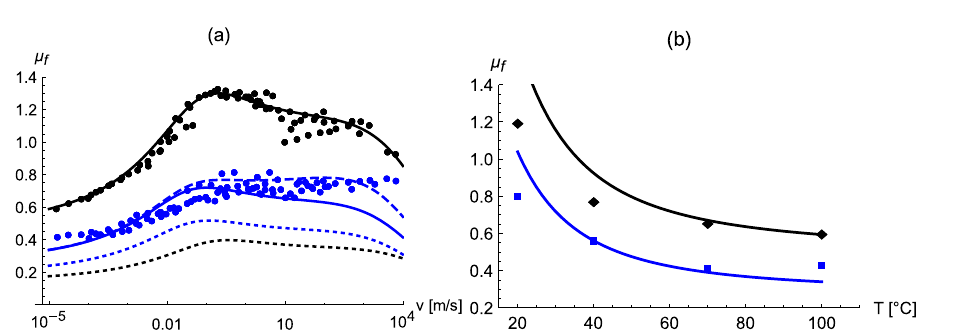
Figure 2. ( a ) Master curves from Fig. 10 of Ref. 25 for coarse granite. Black dots: P = 1 bar; blue dots: P = 7 bar. Reference temperature: T = 70 °C. The lines represent our scaling theory. Solid black line: Fit of µ f ( P = 1 ) using Eq. (14); solid blue line: µ f ( P = 7 ) using Eq. (14) with the fit parameter values previously obtained for µ f ( P = 1 ) ; dashed blue line: same as µ f ( P = 7 ) but with H = 0.868 instead of H = 0.858 ; the dotted lines correspond to the solid lines of the same colour when �γ = 25 mJ/m 2 instead of 50 mJ/m 2 . ( b ) Experimental dependence of µ f on temperature T according to Fig. 9 in Ref. 25 (first data point along the velocity axis). The sliding speed is 10 − 4 m/s. Black dots: P = 1 bar; blue dots: P = 7 bar. The line shows the theoretical result obtained with unaltered parameter